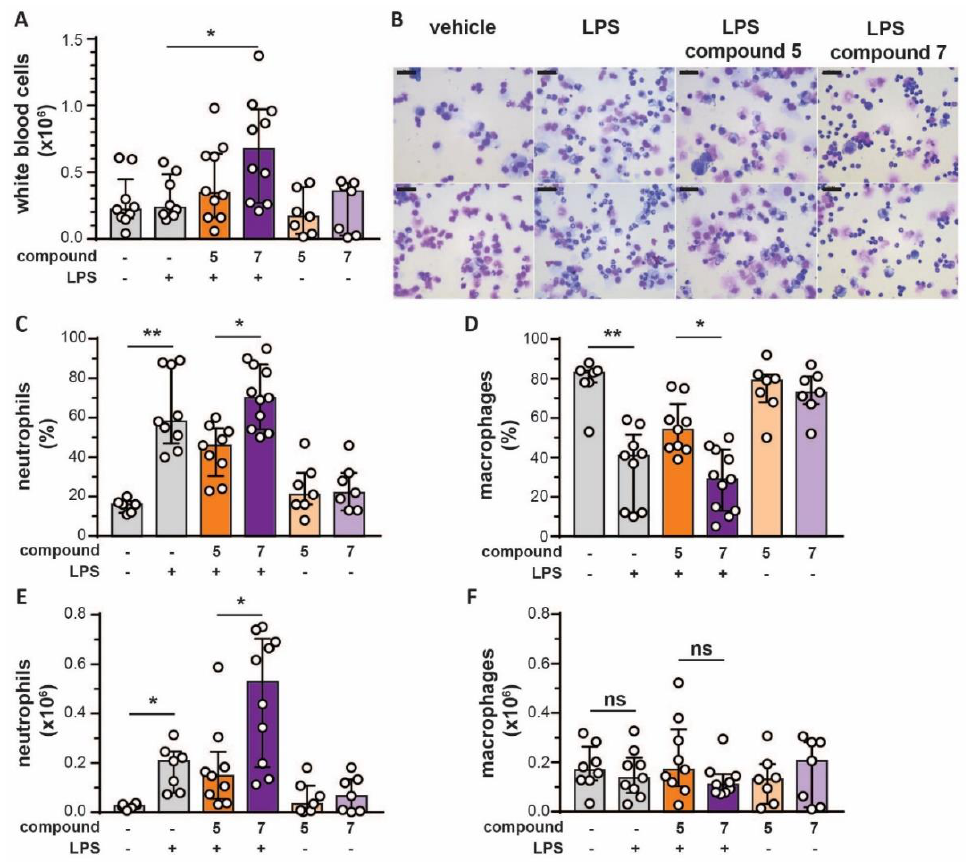
Figure 4. Effects of compounds 5 and 7 on in vivo chemotaxis of neutrophils and macrophages. ( A ) Total amount of white blood cells migrated to subdermal air pouches containing compound 5 (5 µg) and compound 7 (5 µg) in the presence (+) or absence (-) of lipopolysaccharides (LPS) (2 µg), 4 h after injection; ( B ) representative microscopy images of cytospin preparations from cells obtained from air pouches. Two images are shown per condition. Size bars represent 20 µm; ( C ) percentages of neutrophils present in air pouches as determined by differential cell counting of cytospin preparations; ( D ) percentages macrophages present in air pouches as determined by differential cell counting of cytospin preparations; ( E ) total amounts of neutrophils recruited to air pouches; ( F ) total amounts of macrophages recruited to air pouches. Each data point represents a single mouse ( n = 7– 10). * p < 0.05, ** p < 0.01. Bars represent median values and error bars represent interquartile ranges. Data were pooled from three independent experiments. +/- signs indicate, respectively, the presence or absence of LPS (2 µg).